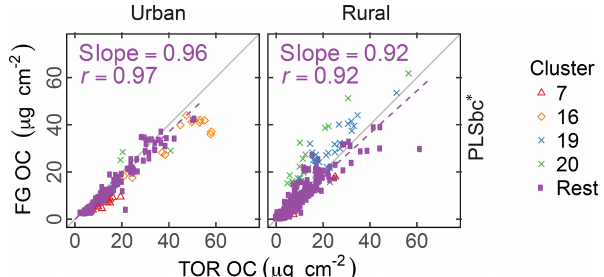
Figure 5. Comparison of estimated OC (FG OC) gainst OC mea- sured by TOR method (TOR OC). PLSbc* refers to partial least square using baseline-corrected spectra and a heuristic choice for the aCH LVs number (13) based on agreement between FG OC and TOR OC (Fig. S16).